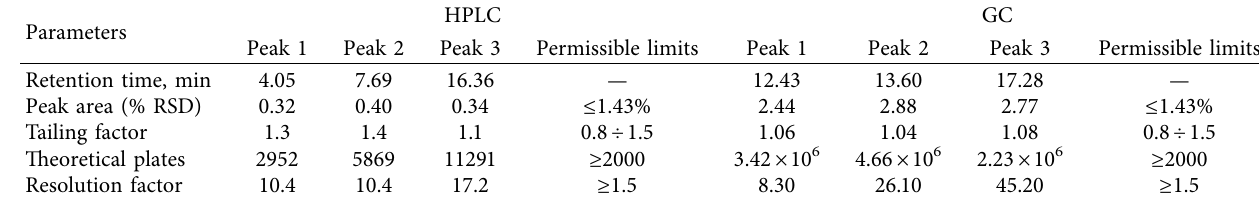
Table 1: System suitability test parameters for BAC by HPLC and GC